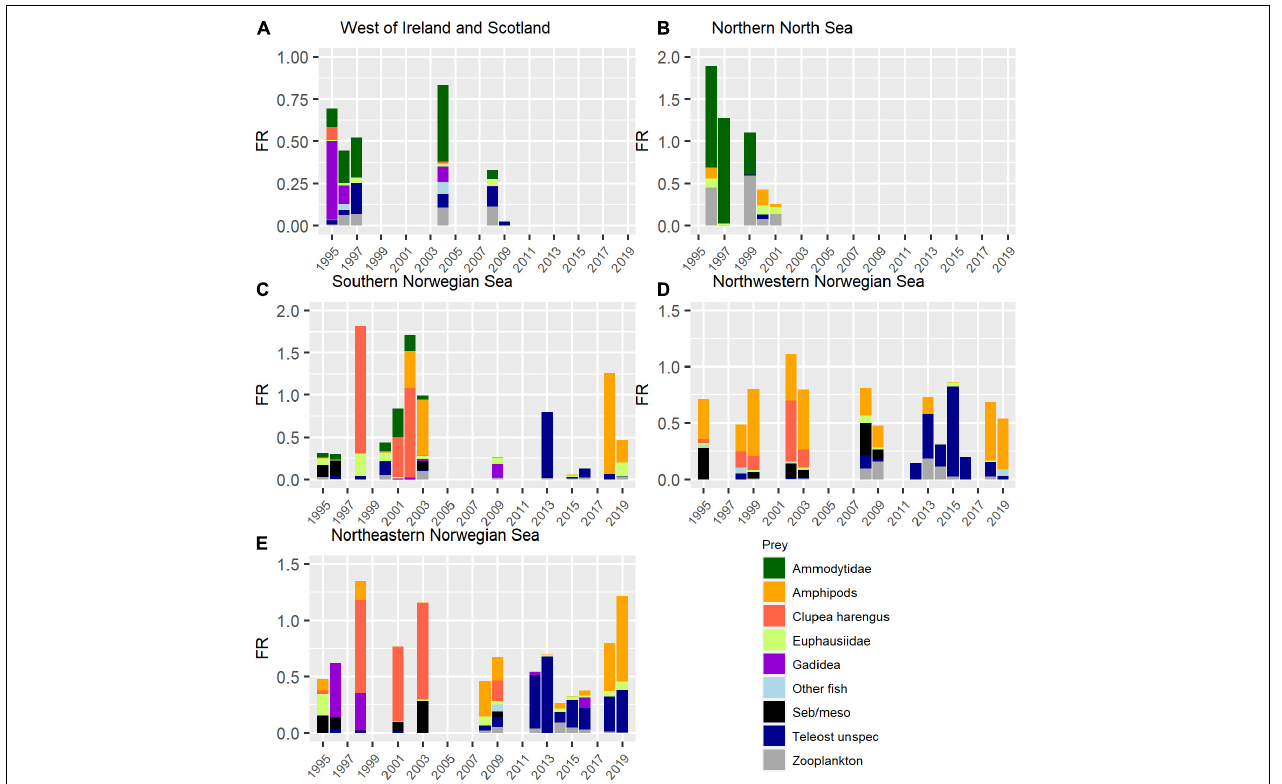
FIGURE 2 | Histograms of annual average FR values for different regions, where each annual value split into prey groups (by weight). The regions are (A) West of Ireland and Scotland, (B) Northern North Sea, (C) Southern Norwegian Sea, (D) Northwestern Norwegian Sea, and (E) Northeastern Norwegian Sea. The figure was produced with the use of the following R-packages: ggplot2 (Wickham, 2016) and gridExtra (Auguié,